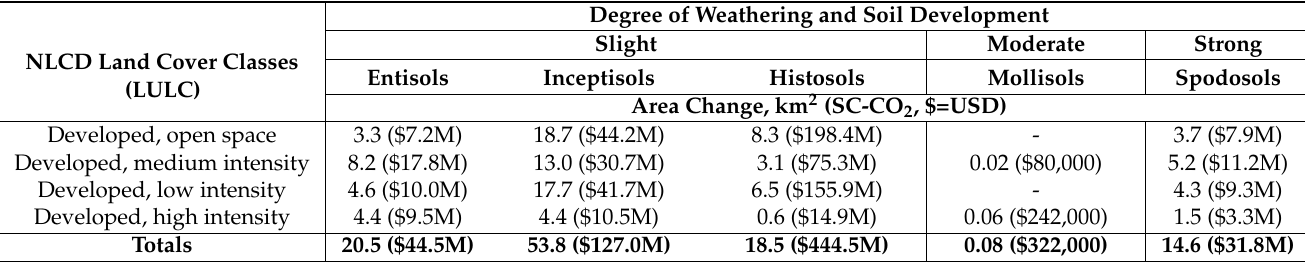
Table 13. Increases in developed land and maximum potential for realized social costs of carbon due to complete loss of total soil carbon of developed land by soil order in New Hampshire (USA) from 2001 to 2016. Values are derived from Tables 4 and 11.